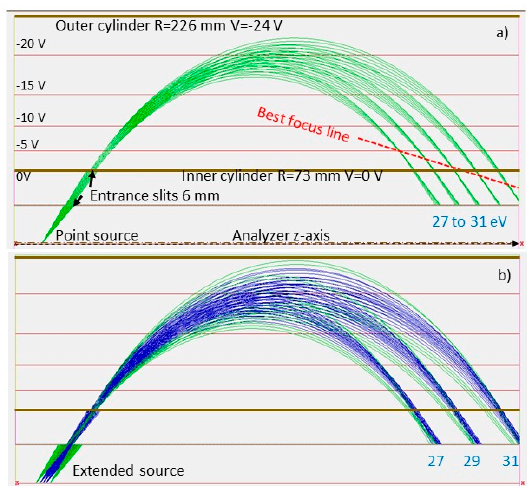
Figure 1. ( a ) SIMION ® simulation of electron trajectories, starting from a source point, inside an ideal cylindrical analyzer for energies from 27 to 31 eV with V in –V out = 24 V (the field varies as 1 / r) and elevation angles from 50 ◦ to 60 ◦ (around the 54.4 ◦ magic angle). The two 6 mm entrance slits limit the acceptance angle. The focus on the inner cylinder is for K.E. ~ 29 eV. ( b ) Simulation for an extended source. The trajectories of electrons starting from the central 6 mm zone (blue trajectories) are not cut by the first slit, while electron from the two zones of 7 mm before and after are limited by the most inner slit. They induce an asymmetric broadening of the electron peak. Atoms 2020 , 8 , x FOR PEER REVIEW